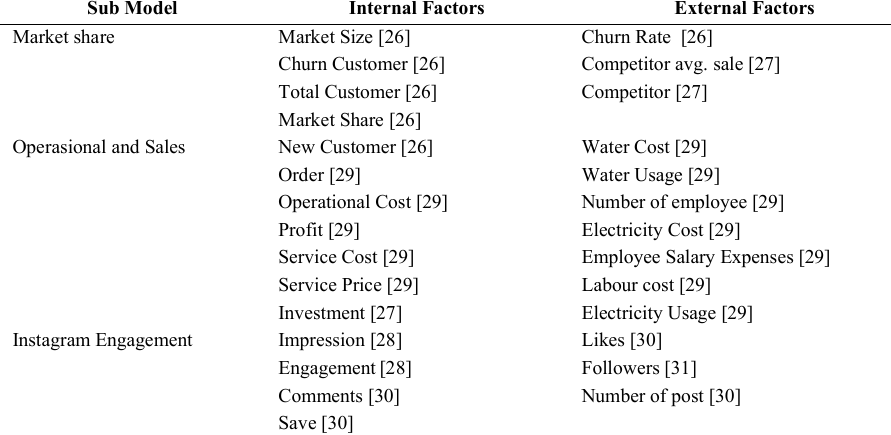
TABLE 1 S TRUCTURE V ALIDATION AND T HE S